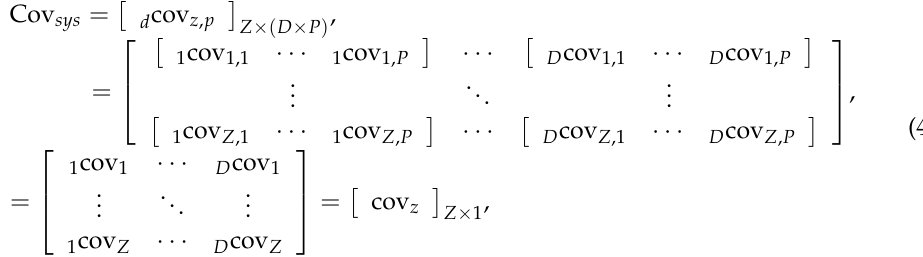
where d = 1, . . . , D , d cov z , p indicates the detection area of the p th PIR module in the d th detector which covers Zone ( z ) . Note that d cov z , p = 0 ( reap. 1) indicates Zone ( z ) is not covered ( reap. covered )), cov z = in this